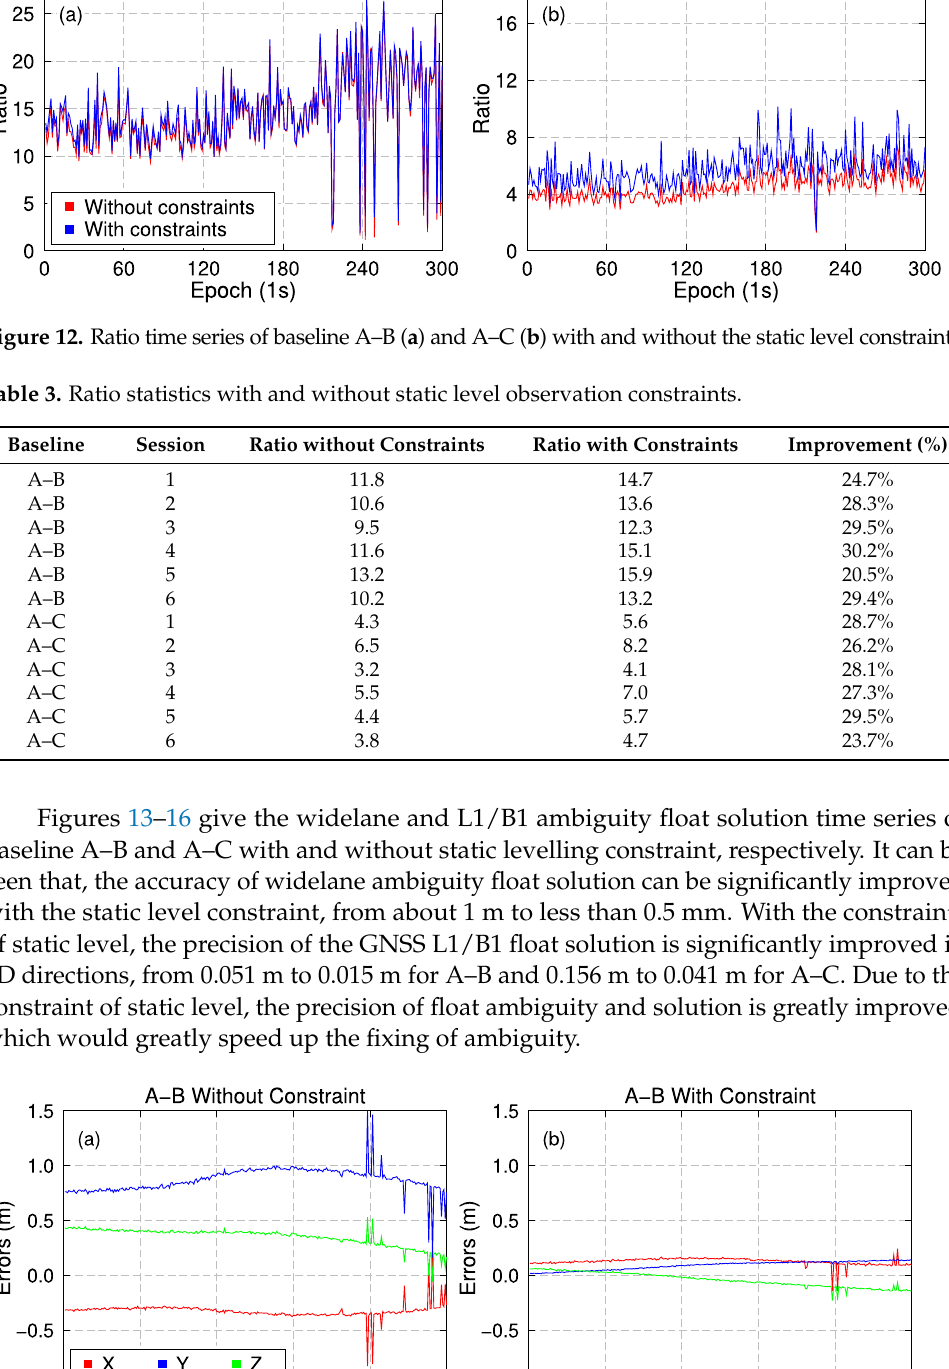
Figure 14. L1/B1 ambiguity float solutions of baseline A–B without ( a ) and with ( b ) static levelling constraint. Figure 15. Widelane ambiguity float solutions of baseline A–B without ( a ) and with ( b ) static level- ling constraint. Figure 16. L1/B1 ambiguity float solutions of baseline A–C without ( a ) and with ( b ) static levelling constraint.